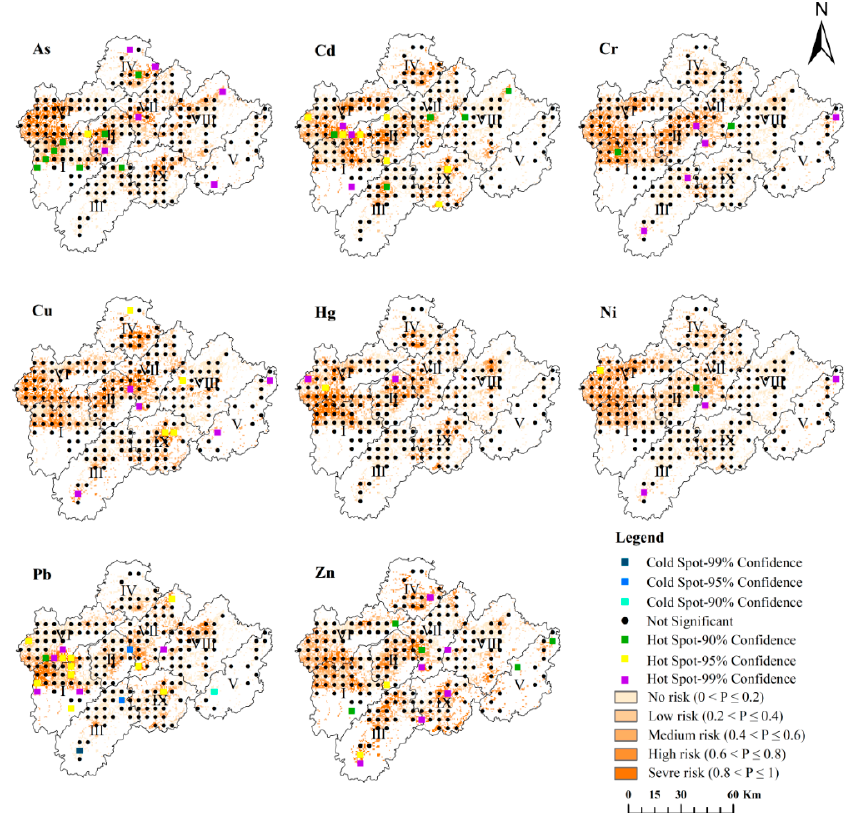
Figure 3. Distribution of hot spots and environmental risk probabilities of soil heavy metals of farmland area in Jinhua City. Hot/Cold spot—99% confidence: significant statistical hot/cold spots with 99% confidence; Hot/Cold spot—95% confidence: significant statistical hot/cold spots with 95% confidence; Hot/Cold spot—90% confidence: significant statistical hot/cold spots with 90% confidence; I: Wucheng District; II: Jindong District; III: Wuyi County; IV: Pujiang County; V: Pan’an County; VI: Lanxi City; VII: Yiwu City; VIII: Dongyang City; IX: Yongkang City.